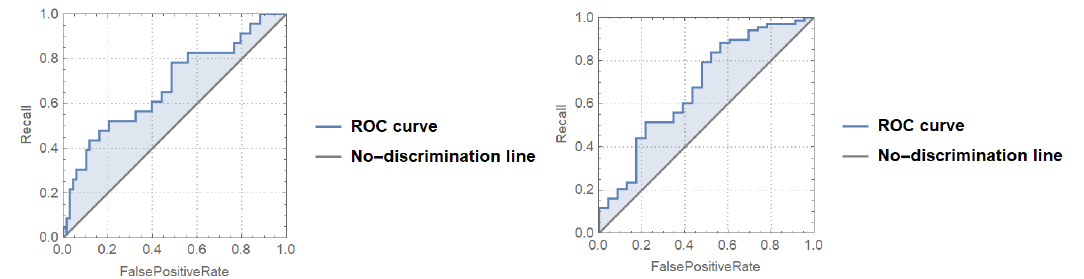
Figure 4. Receiver operating characteristics curves for the classification of lower creative ( left ) and higher creative ( right ) fluency lists for a single trial with 50/50 split and a logistic regression classifier. The AUC is 0.68, which is higher than the no-discrimination case (0.5). The area is highlighted in blue for both